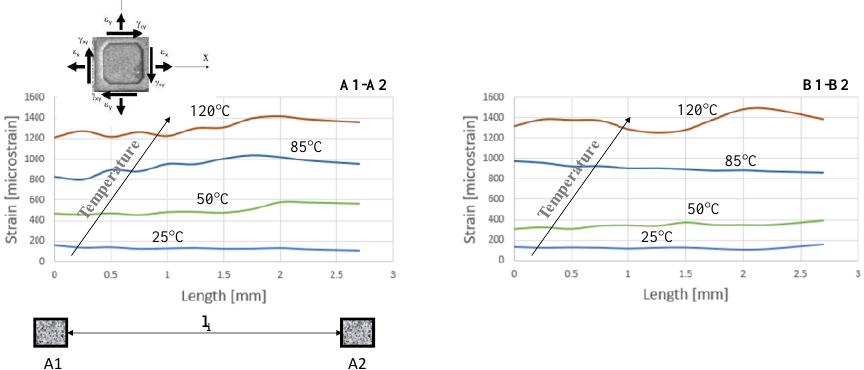
Figure 6. Principal strain DIC according to A1 – A2 and B1 – B2 paths. The principal strain is evaluated as: